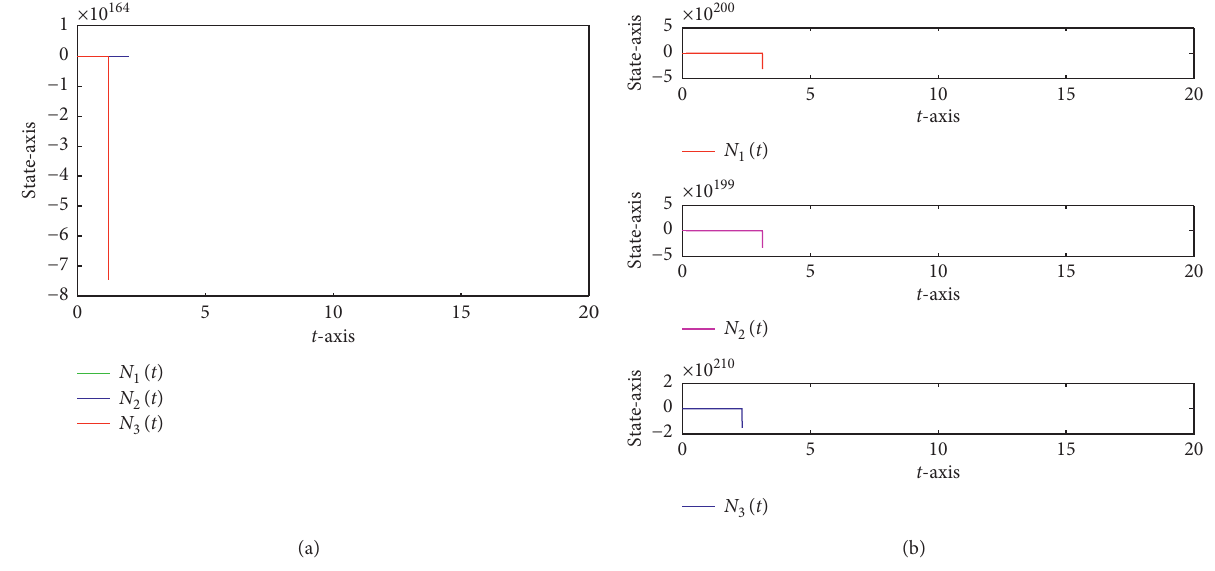
� 0 . 2 , σ � 0 . 1 , σ � 0 . 3 , and τ � 0 . 8. Simulations reveal that too large time delay 1 2 3